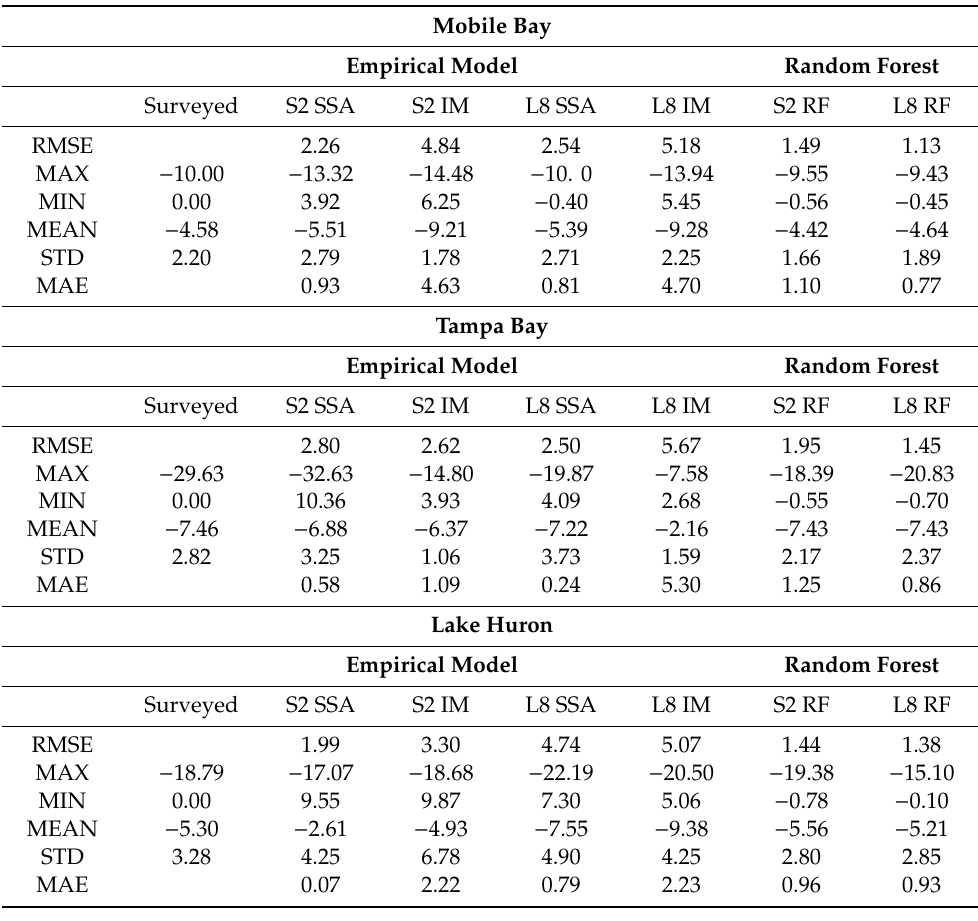
Table 2. Statistical analysis of accuracy assessment from di ff erent satellite-derived